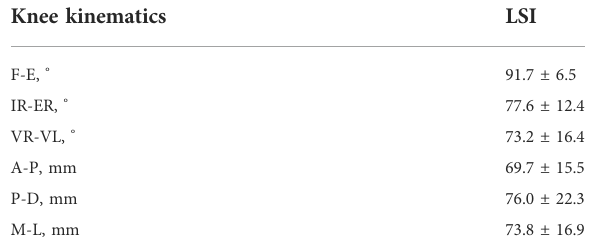
TABLE 3 Knee kinematics outcomes.